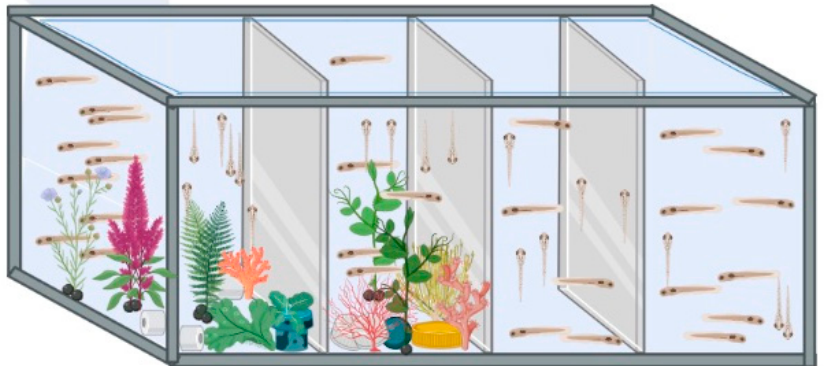
Figure 1. Environment conditions. The image shows the lab-designed hatch tanks. The two tanks on the left are those with EE environments, and the two on the right are those with the PL environments. Tank dividers were opaque. Larger tanks had a similar arrangement.